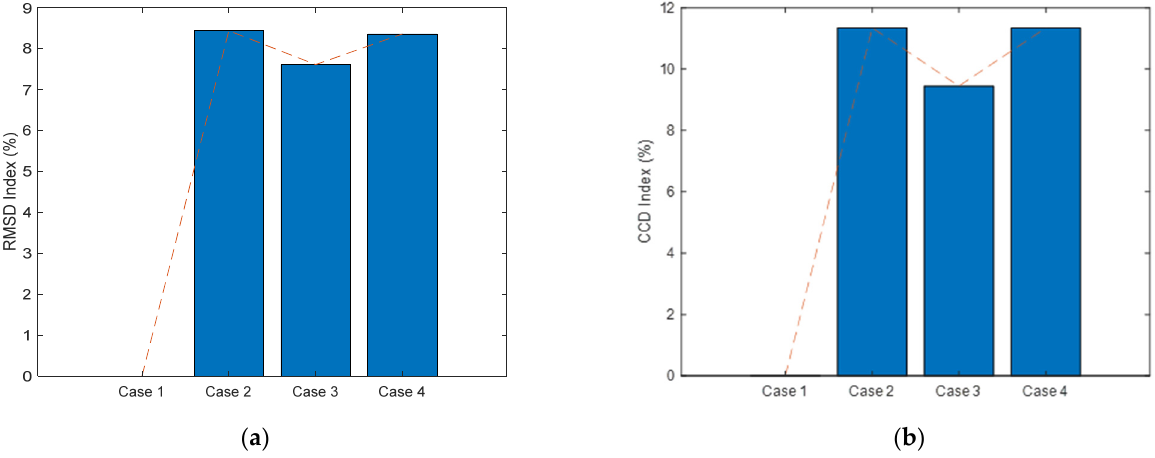
Figure 12. The damage indices for the frequency range of 20–40 kHz. ( a ) RMSD index; ( b ) CCD index.